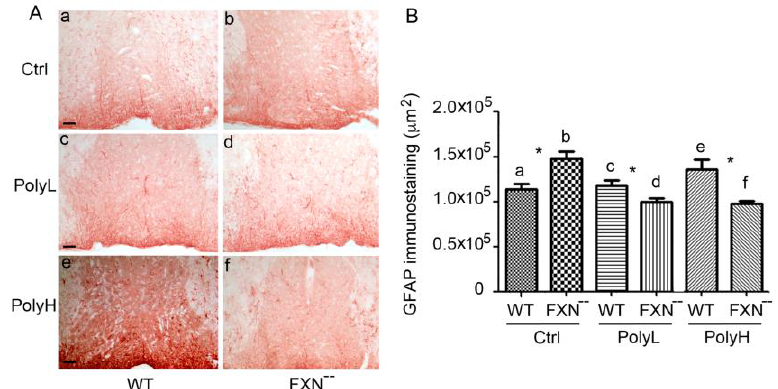
Figure 9. ( A ): Expression of the Glial Fibrillary Acidic Protein (GFAP) in the dorsal funiculus of the spinal cord from 6 month-old wild types (WT) and Frataxin mutant (FXN – ) mice. Spinal cord coronal sections labeled by GFAP antibodies, demonstrate an increase of this glial marker in the dorsal funiculus of mutant mice in control conditions (Ctrl), which indicated the occurrence of reactive gliosis therein, reflecting protective e ff ects against the oxidative damage. On the other hand, in the presence of low dosages (PolyL; 0.0185 mg / g, c,d) and mostly high dosages (PolyH; 0.185 mg / g, e,f) of EGCG treatment, GFAP expression was significantly downregulated. Scale bar: 50 µ m. ( B ): The bar graphs report on the morphometric evaluation of the GFAP labeling shown in ( A ), expressed as the pixel per field. The GFAP levels were found to be increased by a 22% value in FXN – mice compared to WT in control conditions with a statistically significant p -value of 0.01, indicated by * (a,b), while a significant downregulation was observed upon EGCG treatment, under both concentrations used (c,d and